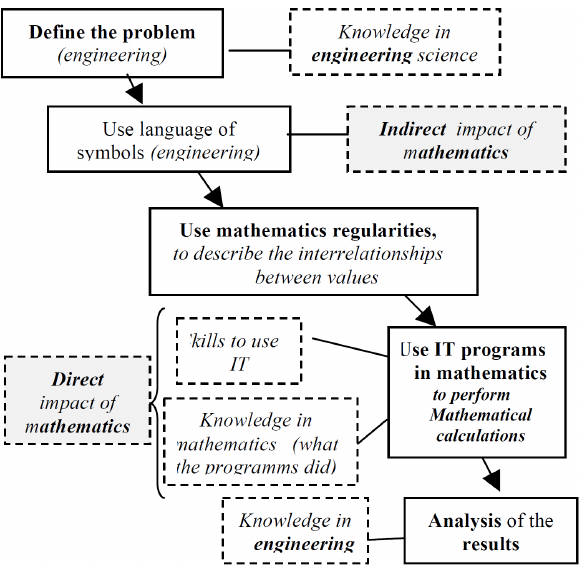
Figure 10. Mathematics impact in Engineering Education